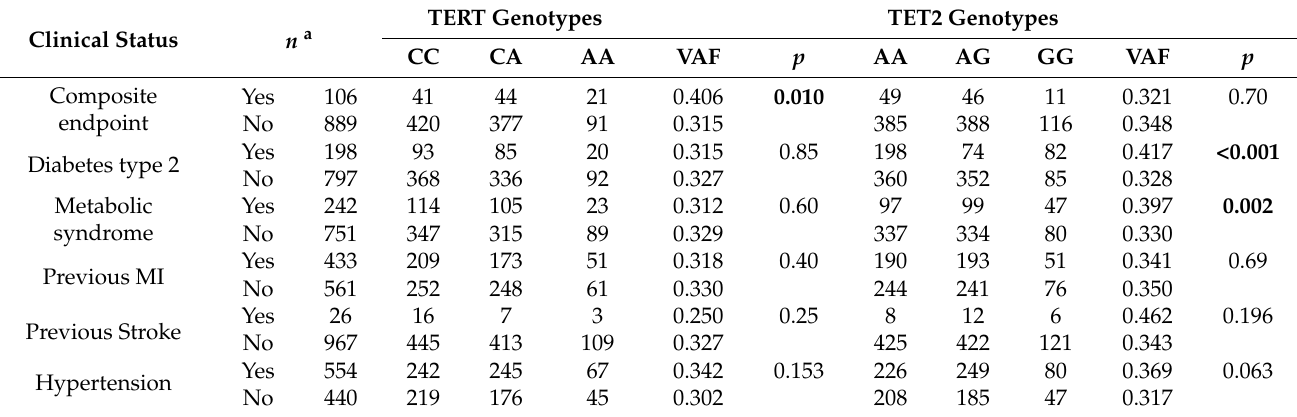
Table 3. The presence of the TERT rs7705526 and TET2 rs2454206 genetic variants in the CAD population, as related to clinical outcome after 2 years, and comorbidity at